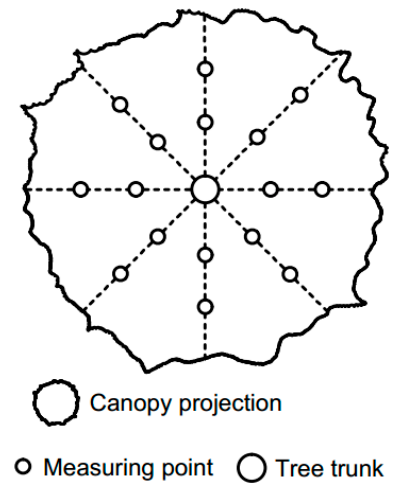
Figure 2. Measuring points under the canopy.